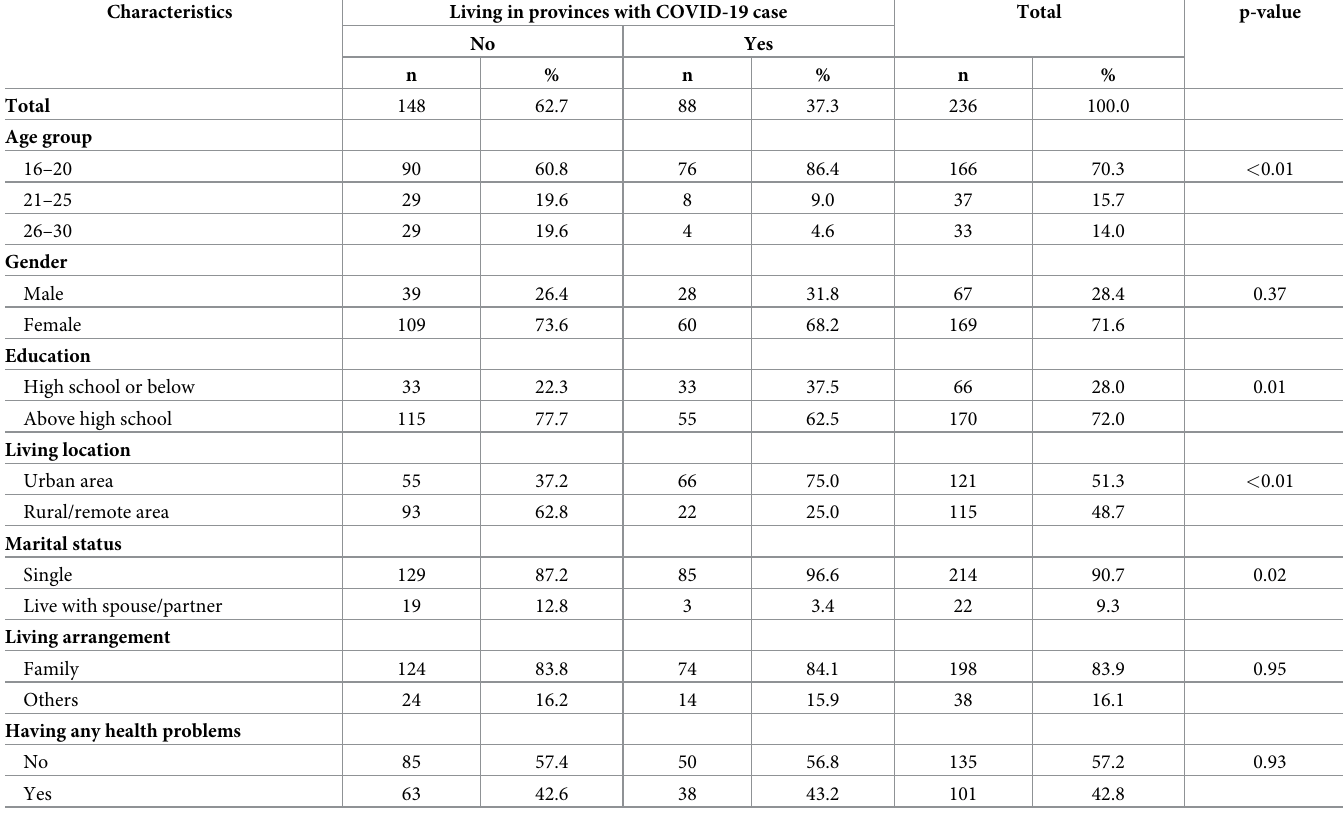
Table 1. Demographic characteristics of participants (n = 236).